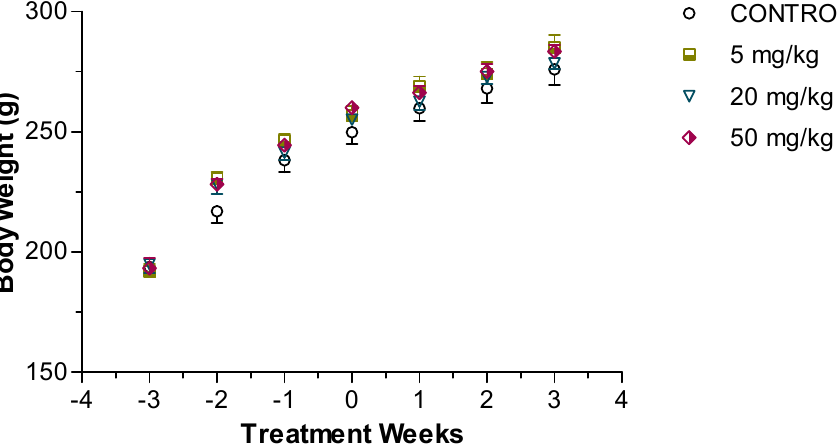
Figure 2. Average weekly body weight of control and HON-treated spontaneously hypertensive male rats. Data are presented as mean ± SEM, with each data point representing n = 8. No statistically significant differences were detected between control and treated rats.